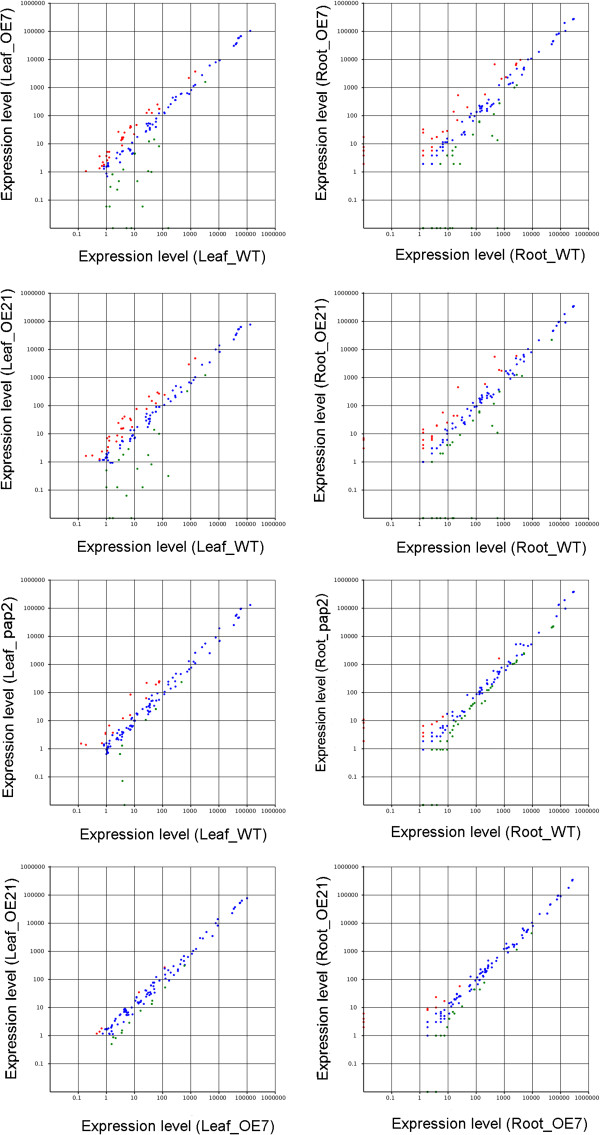
Scatter plot of known miRNAs (Leaf and root). Red dots: Increase in abundance (ratio > 2, P < 0.05); blue dots: Equal expression (1/2 < ratio ≤2); Green dots: Decrease in abundance (ratio ≤ 1/2, P < 0.05). In all the presented figures, X-axis indicates control while Y-axis indicates treatment sample.